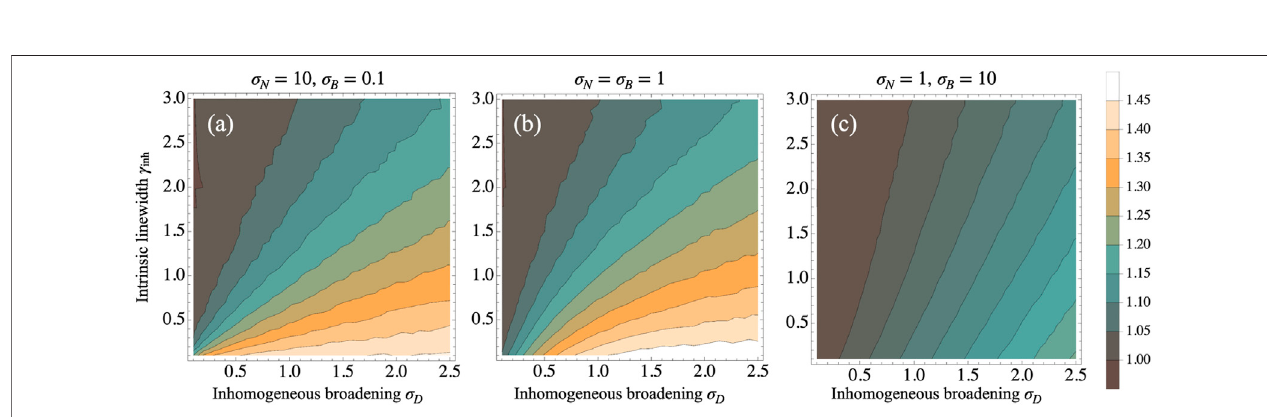
FIGURE4| Ratiooftheabsorptionprobability (23) betweenETPAinaninhomogeneouslybroadenedsampleandinahomogeneouslybroadenedsamplewiththe same linewidth broadening is plotted for three different input states vs. the intrinsic linewidth and the inhomogeneous broadening. As indicated above the contourplots, the parameters are chosen as (A) σ N = 10and σ B =0.1, i.e. atwo-photon state featuringstrong frequencyanti-correlations, (B) σ N = σ B =1, i.e.almost separable photon pairs, and (C) σ N = 1 and σ B = 10, i.e. a state featuring strong positive frequency